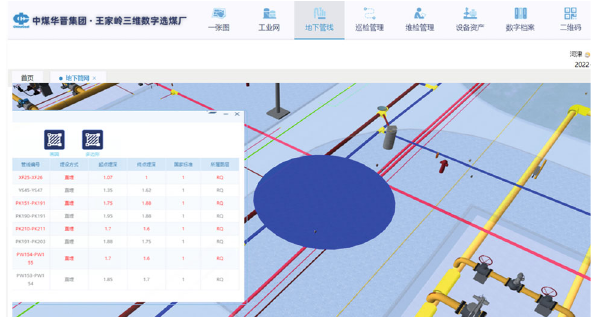
Figure 7: Spatial analysis of underground pipe network of Wangjialing Coal Preparation Plant.